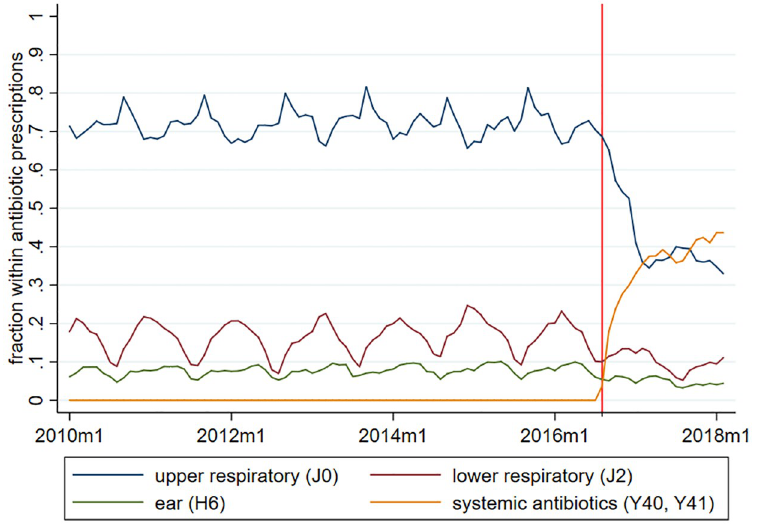
Fig 3. Distribution of antibiotic prescriptions by ICD groups, ages 0-4. The prescriptons are measured in total DOT.